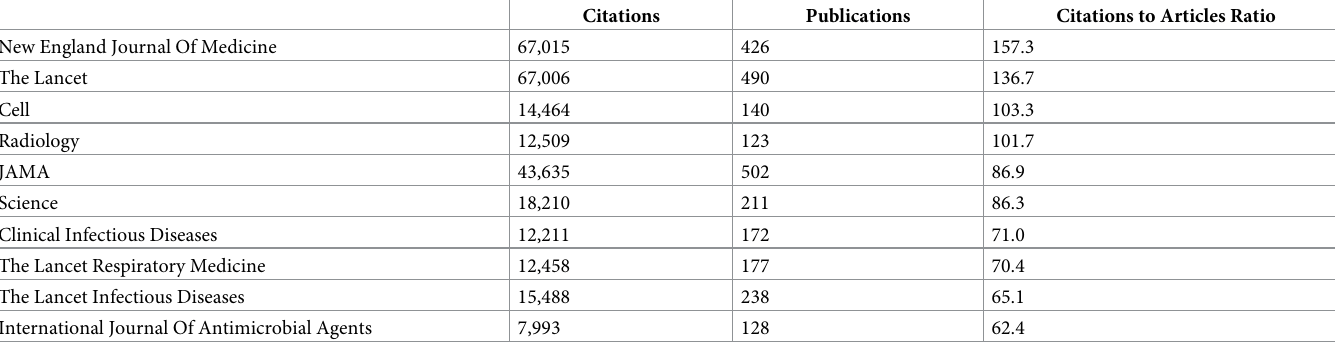
Table 3. The top ten journals in citations to articles ratio among journals with more than 100 publications on